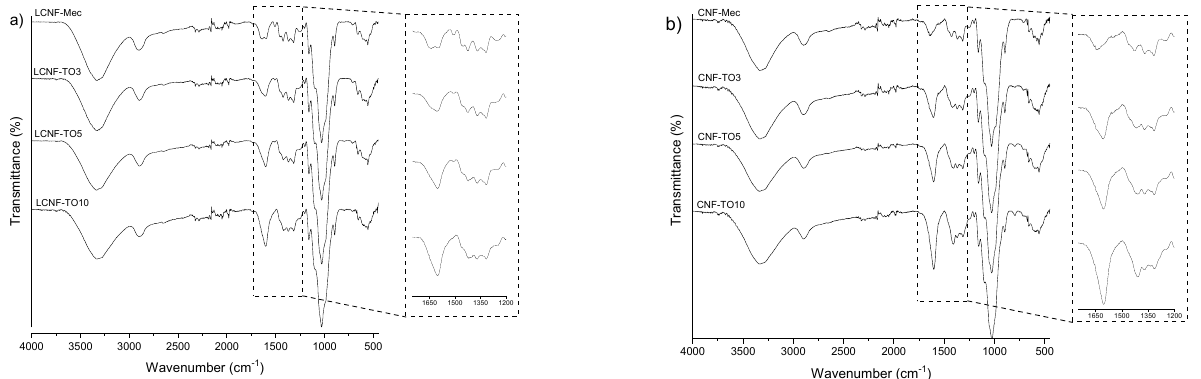
Figure 1. ATR-FTIR spectra of lignocellulosic nanofibers (LCNFs) ( a ), and cellulose nanofibers (CNFs) ( b ).